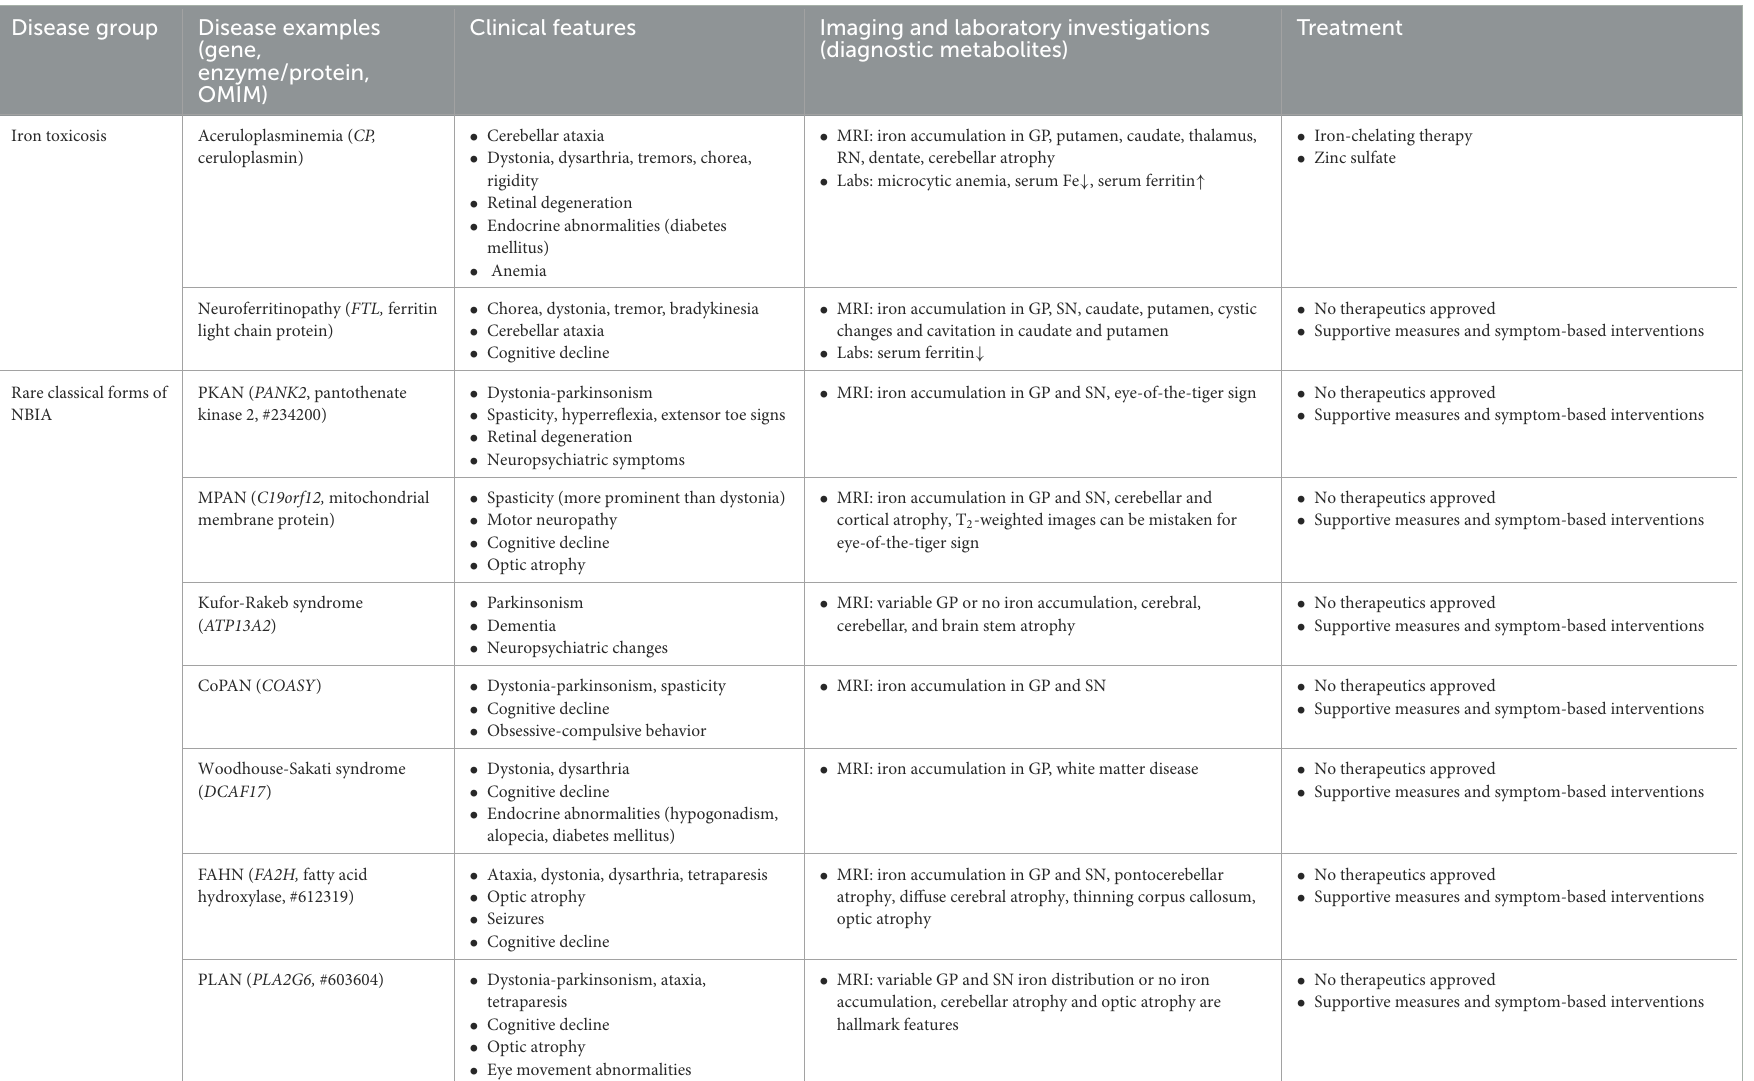
TABLE 4 Selected rare pediatric diseases and inborn errors of metabolism presenting with movement